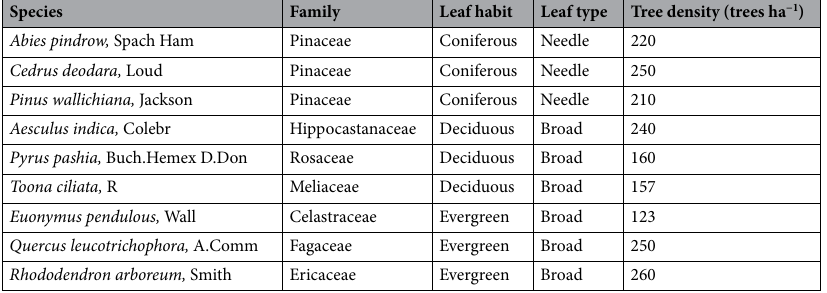
Table 1. Classification of tree species in a temperate forest in Mussoorie Forest Division, Uttarakhand, Indian Himalayas. ( Abies pindrow (40132), Cedrus deodara (70684), Pinus wallichiana (151787), Aesculus